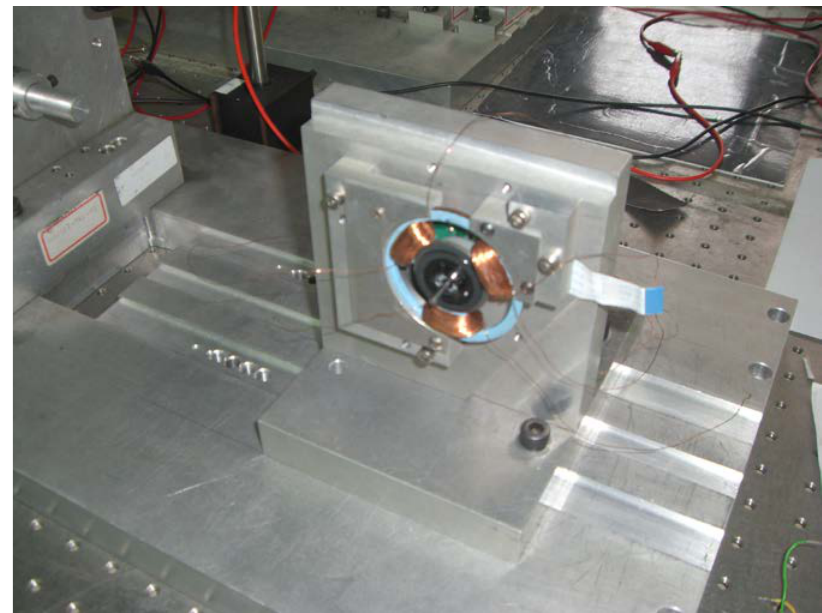
Figure 3. The 3-pole AMB system under study.